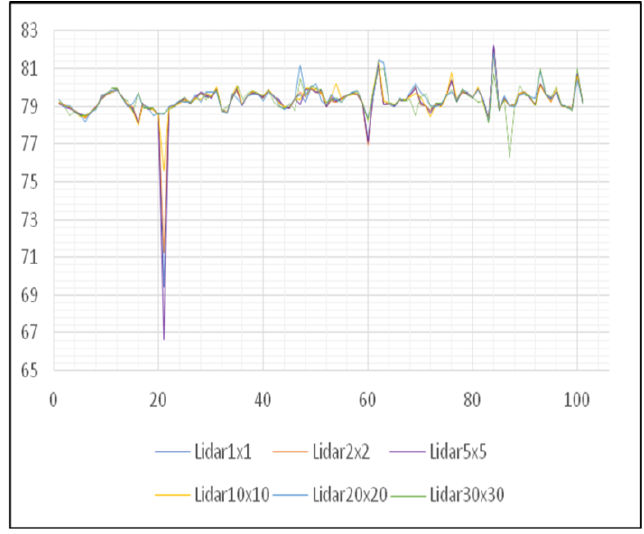
Figure 9. Movement of height values of the DEM of the Center area.